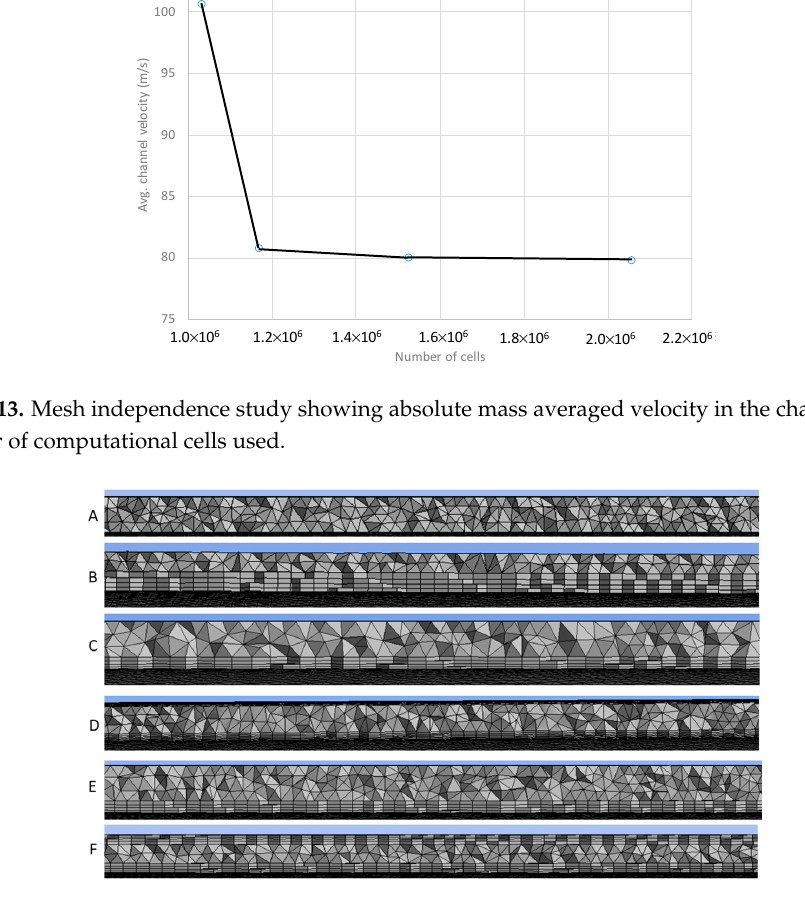
Figure 14. Variety of meshes used: ( A ) 1,032,292 elements, no inflation, max. gap velocity = 166.717 m/s, ( B ) 1,026,658 elements, inflation (4 layers, 1.2 growth rate (GR), 1 mm layer height (LH)), max. gap velocity = 166.717 m/s, ( C ) 1,169,328 elements, inflation (4 layers, 1.2 GR, 0.5 mm LH), max. gap velocity = 166.717, ( D ) 1,526,354 elements, inflation (8 layers, 1.2 GR, 0.5 mm LH), ( E ) 2,057,948 elements, 4 cells across gap, inflation (4 layers, 1.2 GR, 0.5 mm LH), max. gap velocity = 166.721 m/s, ( F ) 2,139,700 Elements, 4 cells across gap, inflation (4 layers, 1.2 GR, 0.5 mm LH), max. gap velocity = 166.721 m/s.